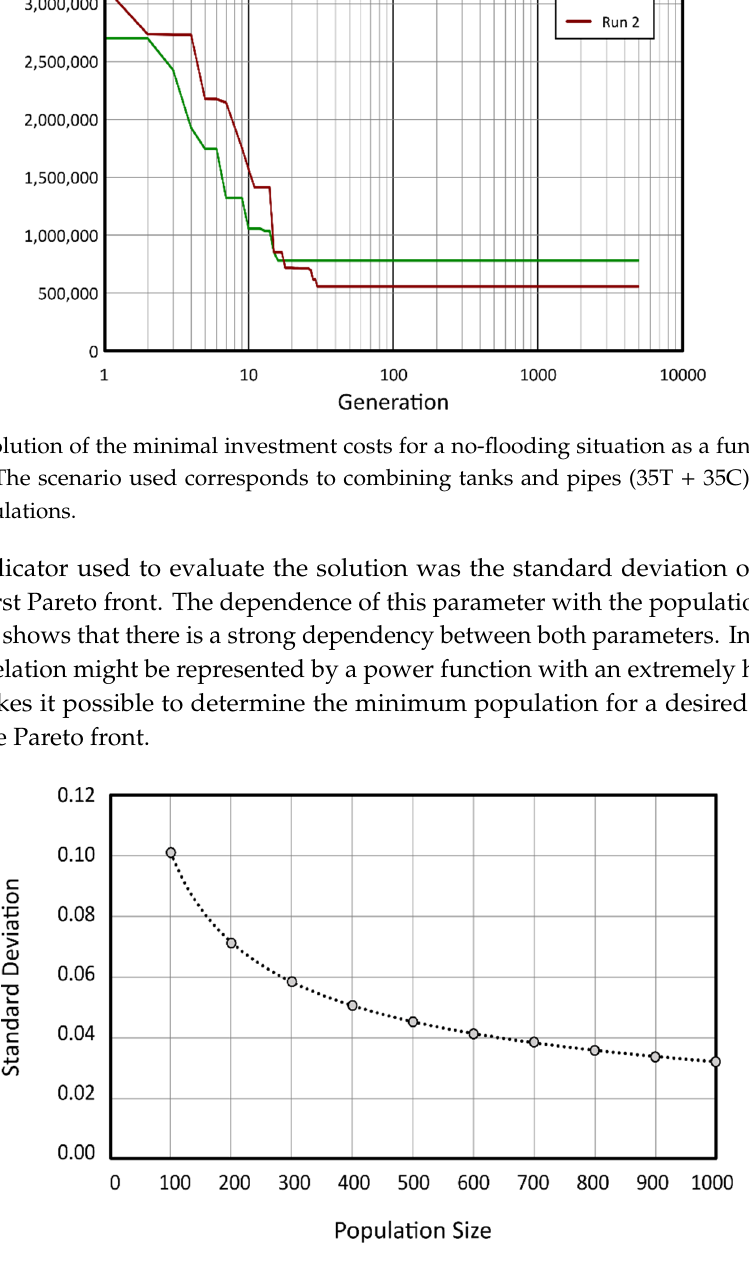
Figure 8. Standard deviation of first Pareto front as a function of population size in the final solution for Scenario 3 (35T + 35C).